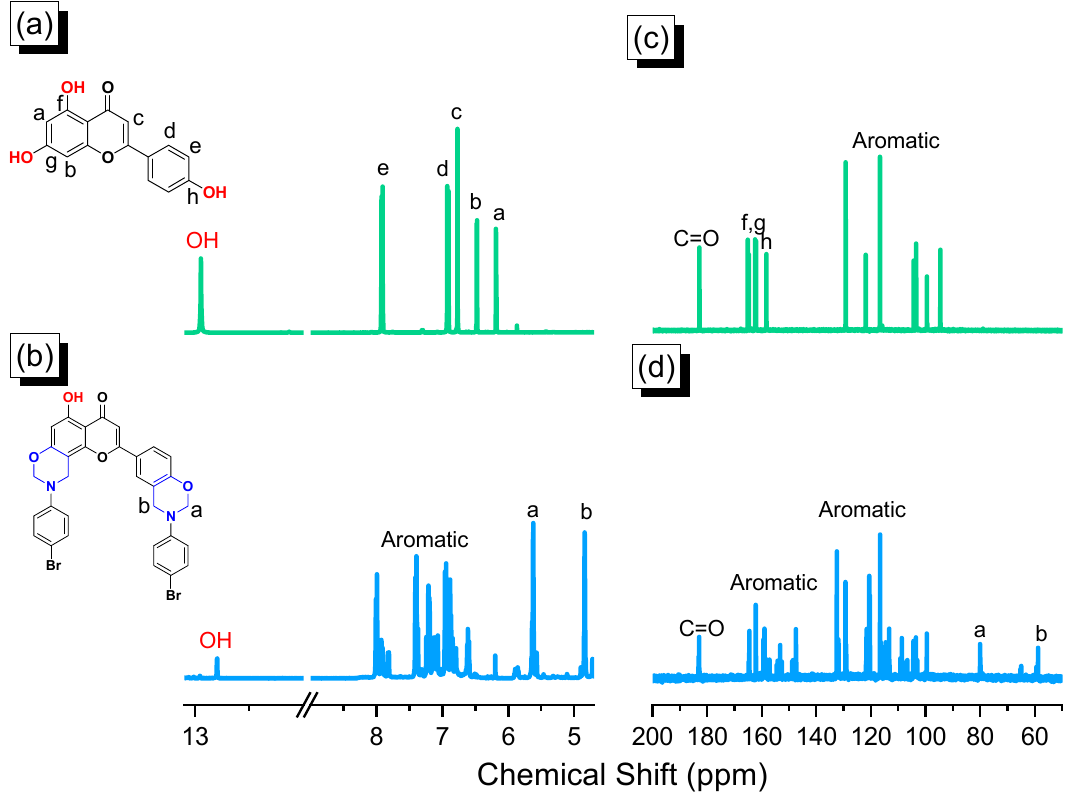
Figure 1. ( a , b ) 1 H and ( c , d ) 1 3 C NMR spectra of ( a , c ) apigenin and ( b , d ) PA-BZ in DMSO-d 6 .